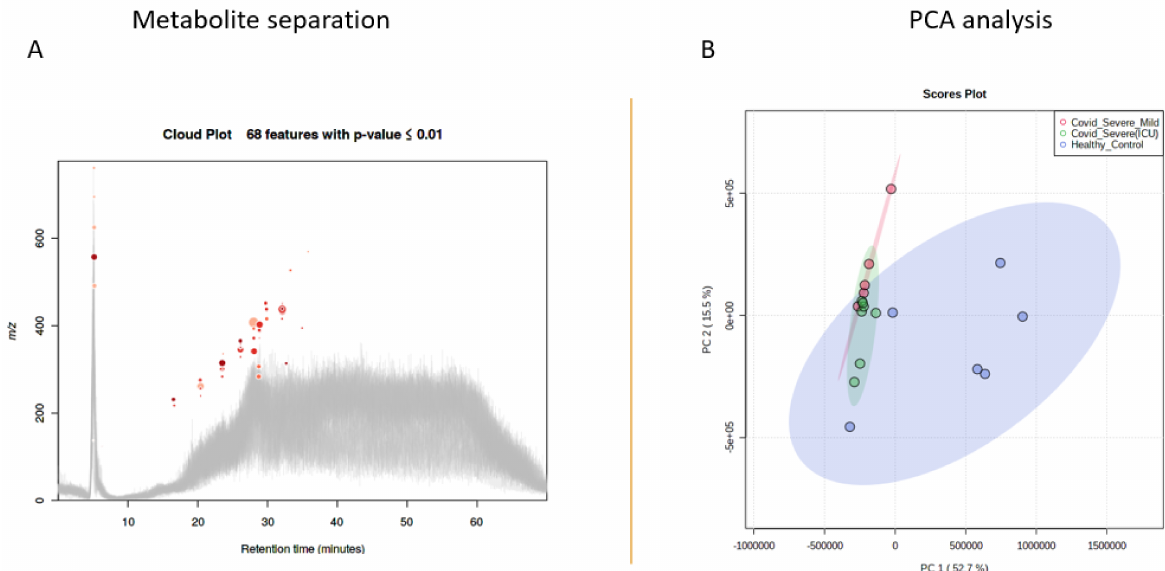
Figure 2. Metabolite separation and statistical analysis. ( A ) Total ion chromatogram of EVs isolated from both healthy and COVID-19 patient samples. ( B ) Scores plot between the healthy and COVID-19 patient samples. The explained variances are shown in